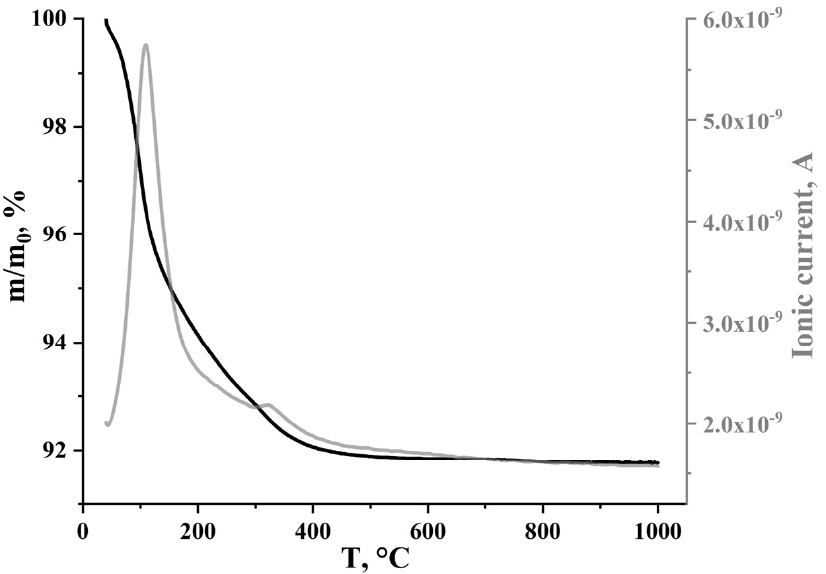
Figure 6. The results of thermal analysis (in black) and mass spectrum for evolving gas with m/Z = 18 (in grey) of the preceramic samples obtained from pastes after their air drying at room tempera- ture.